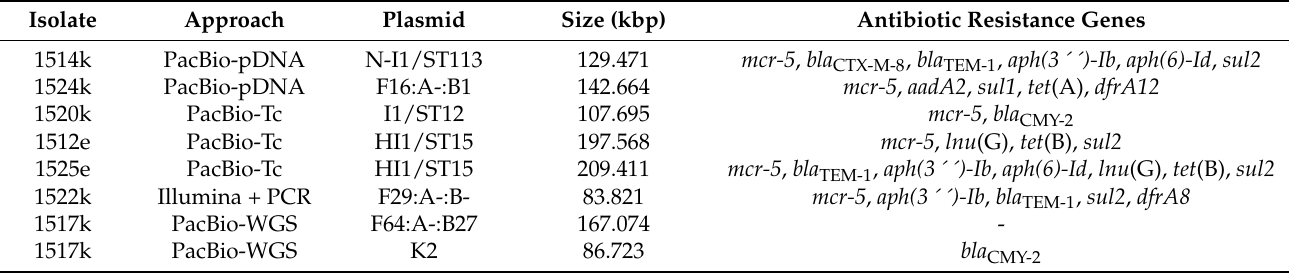
Table 1. Overview of plasmids with complete structure obtained in this study. The Approach column is specifying how the sequence was obtained, either by PacBio whole-genome sequencing (WGS) and combining the data with Illumina sequences using Unicycler (PacBio-WGS), by PacBio sequencing of respective single-plasmid transconjugant (PacBio-Tc), by PacBio sequencing of plasmid DNA extracted from a single-plasmid transconjugant (PacBio-pDNA) or using Illumina sequencing of Plasmid DNA extracted from single-plasmid transconjugants and closing using PCR (Illumina + PCR).